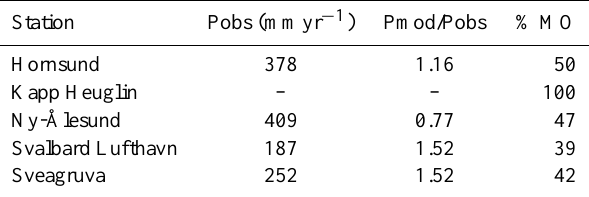
Table 4. 1979–2013 mean annual measured precipitation (mmyr − 1 ), proportion of that precipitation that is simulated by MAR ERA and percentage of missing observations (% MO). Station Pobs (mmyr − 1